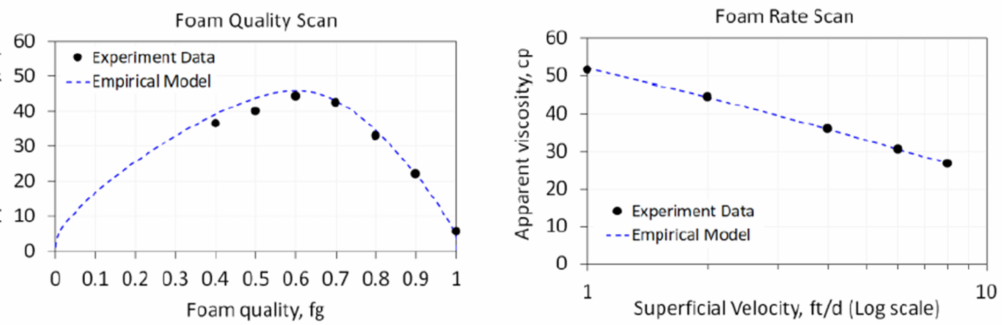
Figure 5. Foam quality scan ( left ) and foam rate scan ( right ) for the base case foam model. The empirical foam model (dashed lines) was fit to experimental data (black dots). Modified from